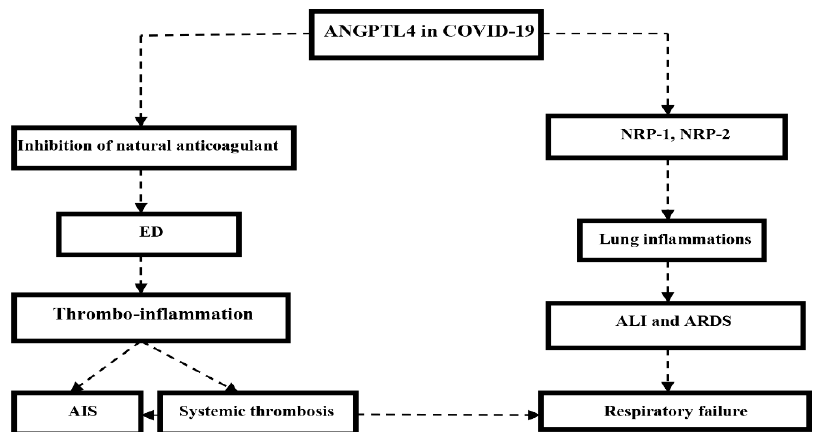
Figure 12. Role of angiopoietin-like peptide 4 (ANGPTL4) in COVID-19: ANGPTL4 through activation of NRP-1 and NRP-2 receptors induces lung inflammation, acute lung injury (ALI), and acute respiratory distress syndrome (ARDS) with the development of respiratory failure. ANGPTL4 through inhibition of natural anticoagulants causes endothelial dysfunction (ED) and the development of thrombo-inflammation leading to systemic thrombosis and acute ischemic stroke (AIS).